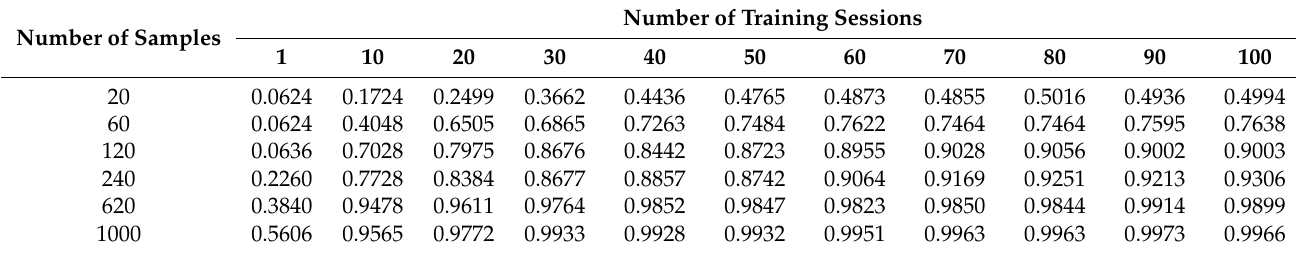
Table 5. Results of experiments without transfer